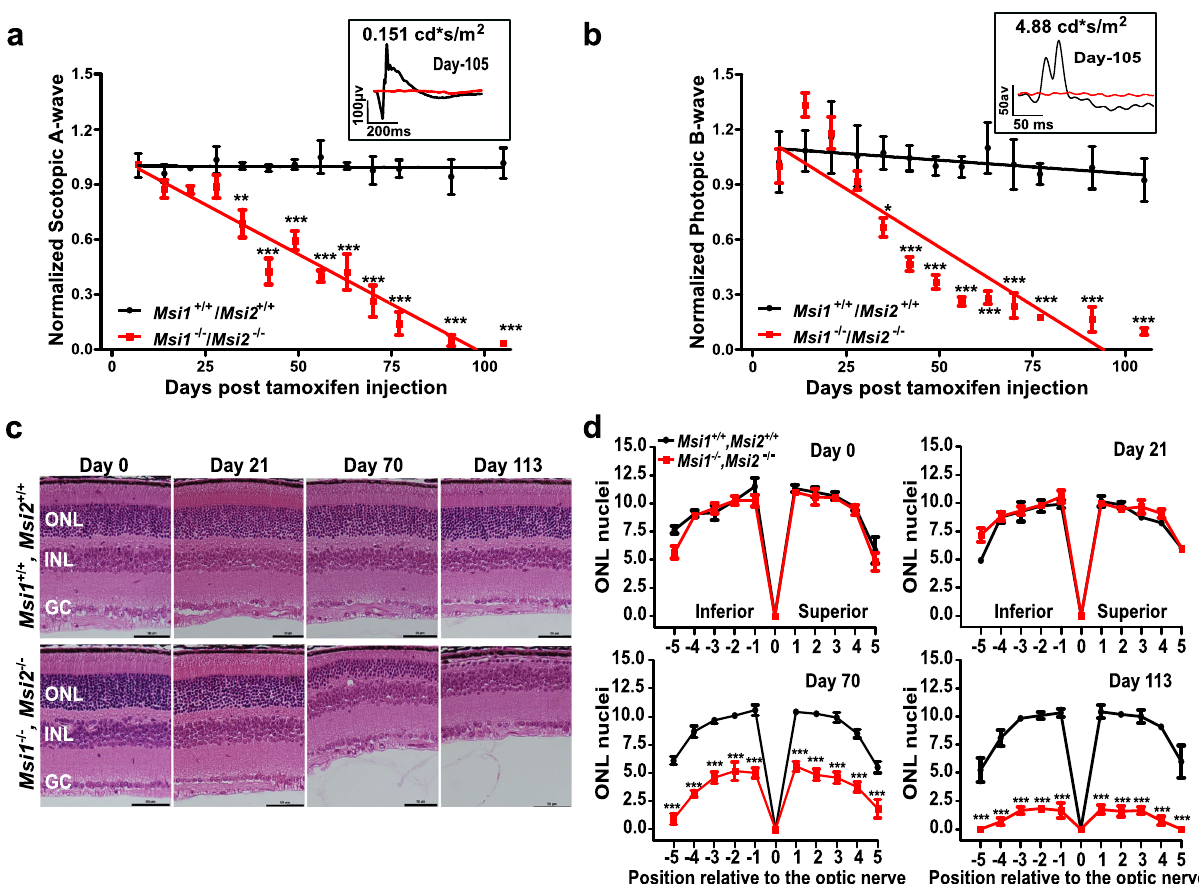
Fig. 2 Progressive loss of response to light and retinal degeneration after double knockout of Msi1 and Msi2 in photoreceptor cells. Time course of scotopic A-wave ( a ) and photopic B-wave ( b ) responses from Msi1 + / + /Msi2 + / + (black line), and Msi1 − / − /Msi2 − / − retinas (red line) following tamoxifen injection. Scotopic and photopic waveforms were obtained 0.151 cd*s/m 2 and 4.88 cd*s/m 2 fl ashes, respectively. Insets show representative electroretinograms from a single Msi1 + / + /Msi2 + / + (black line) and Msi1 − / − /Msi2 − / − (red line) mouse retina at day 105 post-tamoxifen injection. The data points from the scotopic and photopic responses are represented as mean ± SEM of 8 eyes (4 animals). Pairwise t -test with Bonferroni correction for multiple comparisons was used to determine the effect of genotype on the A-wave amplitude at each time point. Signi fi cance levels of the pairwise comparisons is indicated as: * p -value < 0.05, ** p -value < 0.01, *** p -value < 0.001. c Outer nuclear layer degeneration in Msi1 − / − /Msi2 − / − knockout retinas. Representative H&E-stained sections from the Msi1 + / + / Msi2 + / + and Msi1 − / − /Msi2 − / − retinas collected between day 0 and day 113 post- tamoxifen injection. ONL: outer nuclear layer (Photoreceptor nuclei), INL: inner nuclear layer, GC: ganglion cells. 40X objectives and scale bar represents 50 μ m. d Spider plots displaying the thickness of the ONL as the number of nuclei measured at ten points stepped by 400 µ m from the optical nerve at different time points post-tamoxifen injection. Data are shown as mean ± SEM. Pairwise t -test with Bonferroni correction for multiple comparisons was used to determine the effect of the genotype on the outer nuclear layer thickness at each time point. Signi fi cance levels of the pairwise comparisons is indicated as: * p -value < 0.05, ** p -value < 0.01, *** p -value < 0.001. Supplementary Data 15 contains the source data underlying the